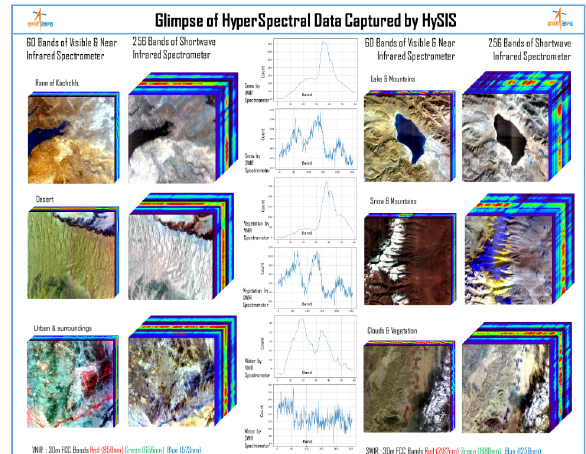
Figure4: Hyperspectral cubes of different terrain conditions & sample spectral plots for different